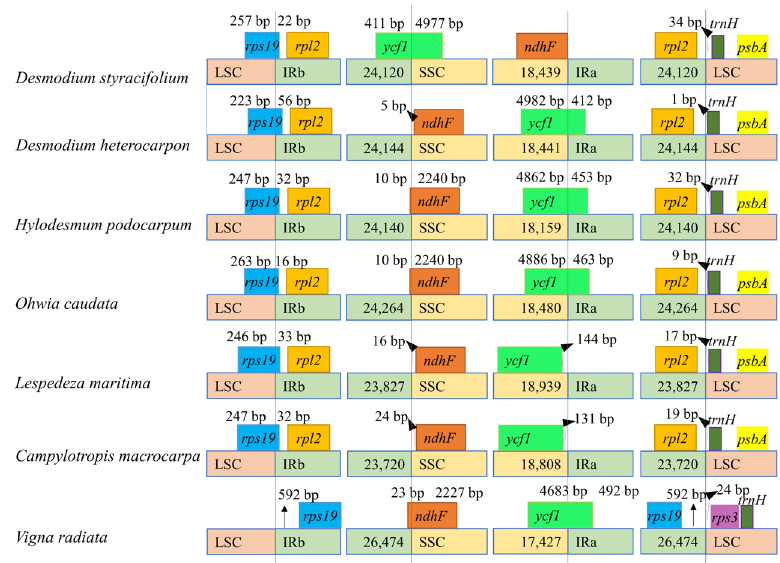
Figure 6. Comparison of the IR/SC junctions among seven chloroplast genomes.